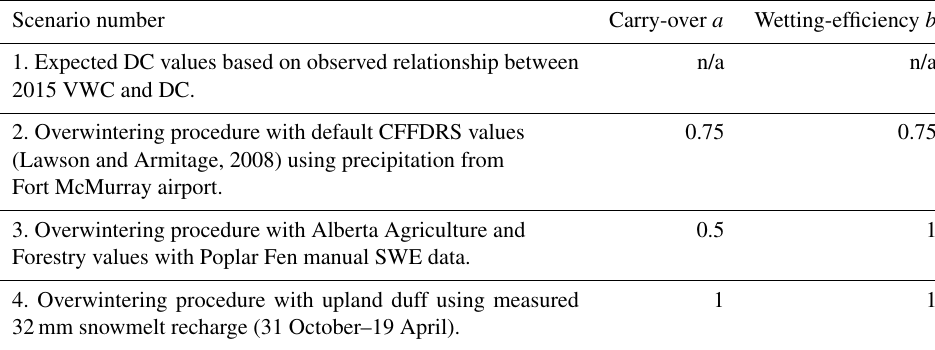
Table 1. Summary of scenarios used for calculating a starting DC for 19 April 2016. Scenario number Carry-over